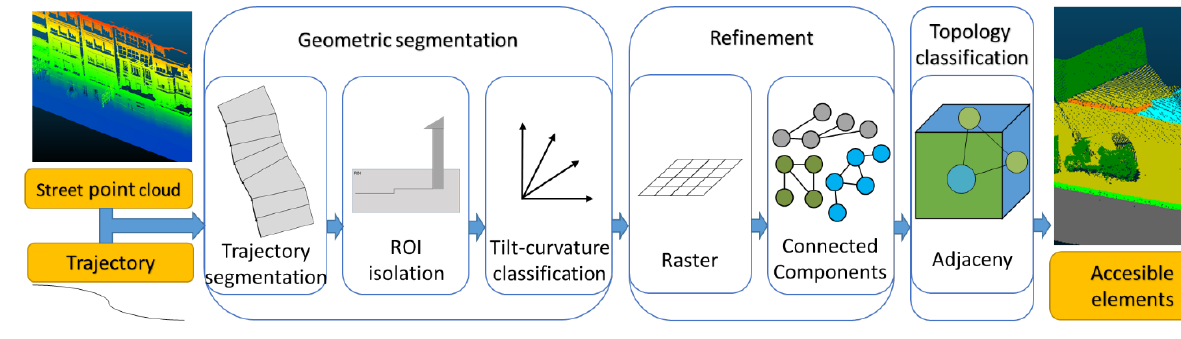
Figure 1. Workflow of the methodology.